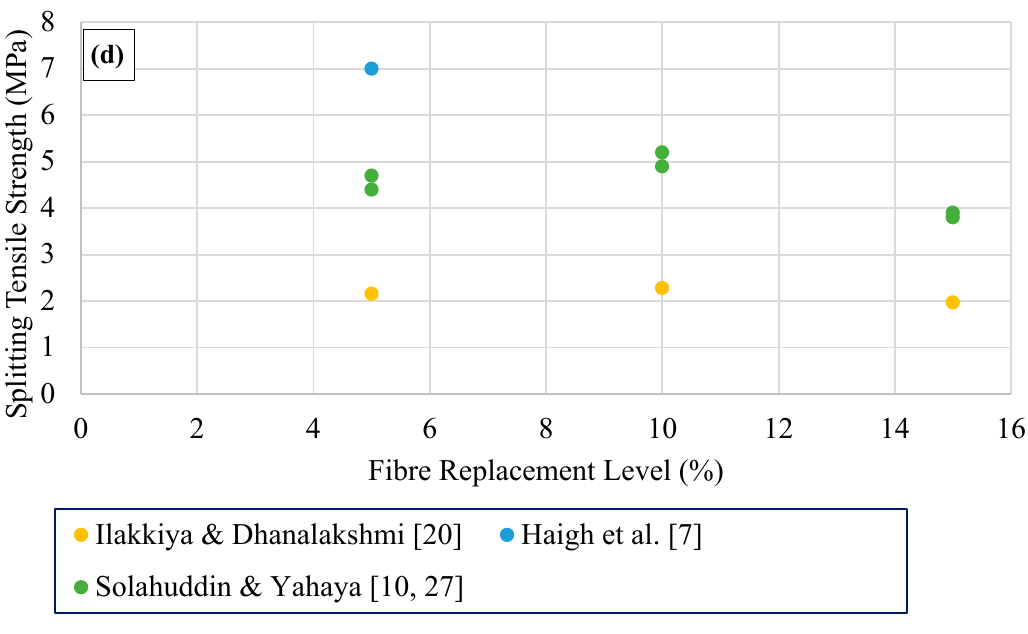
Figure 5. ( a ) Density; ( b ) 28-day compressive strength; ( c ) 28-day flexural tensile strength; and ( d ) 28-day splitting tensile strength variations of waste paper/cardboard cement composite binders.